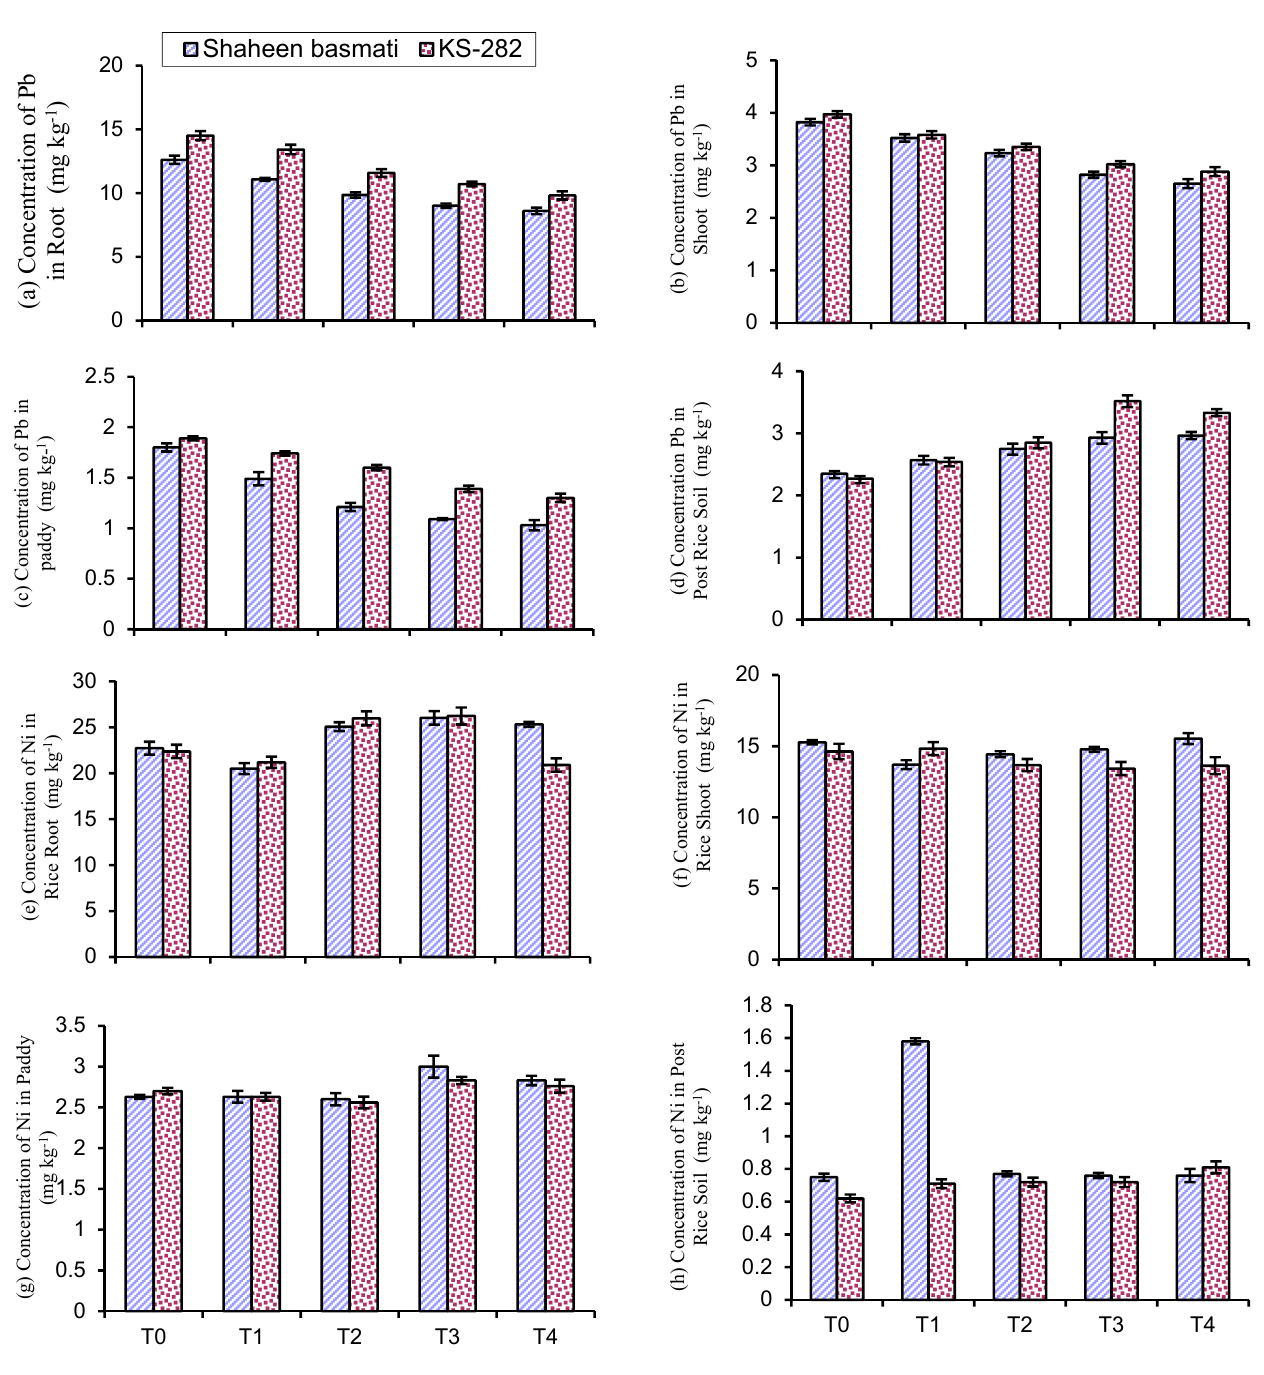
Figure 3. Effect of varying application rates of phosphatic fertilizer on rice tissues concentration of Pb and Ni receiving city effluent irrigation. (Each value is a mean, n = 3 statistically significant at p ≤ 0.05, T bars represents ± SE of means i.e., SEMs). Whereas, T 0 = Control, T 1 = N 170 P 62 K 62, T 2 = N 170 P 124 K 62, T 3 = N 170 P 186 K 62, T 4 = N 170 P 248 K 62. In roots, the decrease in Pb concentration in coarse cultivar was 32.3, 26.2, 20.1 and 10.9% as compared with control treatment. While in fine cultivar the decrease was 31.7, 28.4, 21.8, and 12.2% from the respective control. The highest Pb concentration in shoot of KS-282 was 3.9 mg kg − 1 DW, while in Shaheen basmati it was 3.8 mg kg − 1 DW with treatment T 0 . Furthermore, its concentration reduced to 2.8 mg kg − 1 DW in KS-282 and 2.6 mg kg − 1 in Shaheen basmati with treatment T 4 . In shoot, the decrease in Pb concentration in coarse cultivar was 27.4, 23.3, 15.6, and